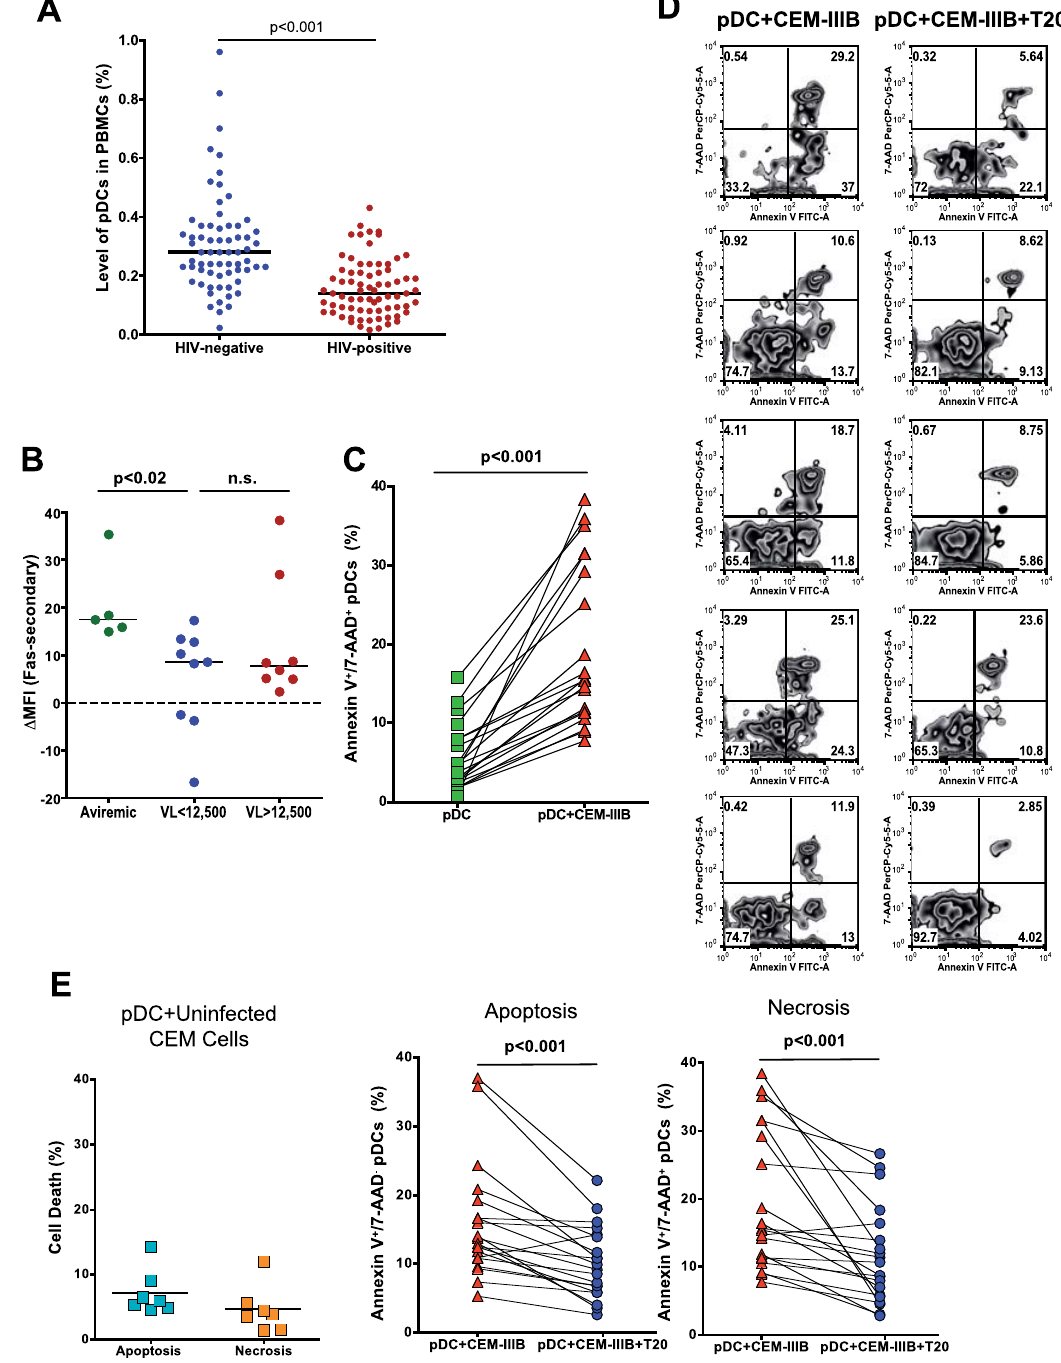
Figure 6. pDC killing in HIV-infected individuals. A) Plasmacytoid dendritic cell numbers are reduced in HIV-infected versus uninfected individuals. PBMCs were stained with anti-BDCA-2 (FITC) and anti-CD123 (PE) to measure the levels of pDCs. Horizontal lines represent median values. B) pDCs are susceptible to Fas-mediated apoptosis. Fas was crosslinked on the surface of PBMCs, and resultant pDC apoptosis was measured by Annexin V staining. n.s., not significant. C–E) pDC cell death induced by HIV-infected cells. 2 6 10 6 CEM cells chronically infected with HIV (CEM-IIIB) were incubated for 8 h with 10 7 PBMCs from HIV-infected donors. The levels of apoptosis and necrosis were assessed by Annexin V and 7-AAD staining. Cells within the pDC (BDCA-2 + /CD123 + ) population that were double-positive for both Annexin V and 7-AAD were considered necrotic, while those positive for Annexin V and negative for 7-AAD were considered apoptotic. In some cultures, 100 m g/ml T20 was added. C) Cells expressing HIV induce pDC death. The percent of pDCs that were necrotic (Annexin V + /7-AAD + ) is indicated on the y-axis. PBMCs alone versus PBMCs + CEM-IIIB are shown. As indicated, CEM-IIIB cells showed a significant induction of cell death vs. cells alone. D) Representative examples of T20-mediated blockade of CEM- IIIB-induced pDC cell death. E) Cell death is blocked by T20. Cells were incubated with CEM cells alone (left panel), CEM-IIIB, or CEM-IIIB + T20, and the percentage of pDCs in the apoptotic or necrotic quadrants was quantified. No cell death above baseline was induced by CEM cells alone. Both types of cell death induced by CEM-IIB cells were significantly reduced (p values indicated) in the presence of T20.